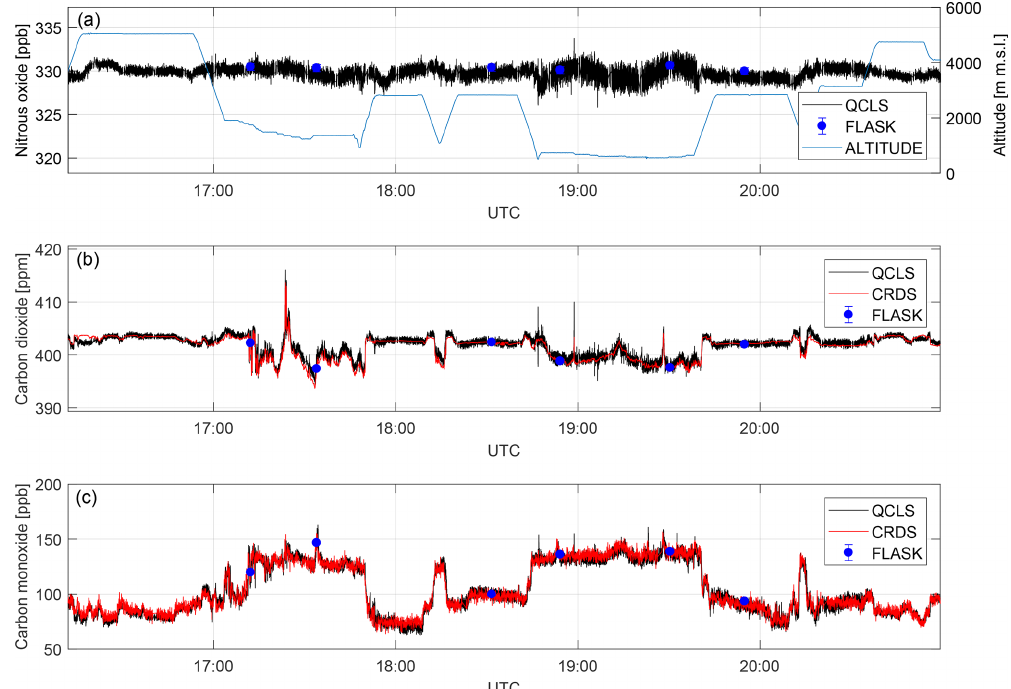
Figure 11. Dry-air mole fractions retrieved from different measurement techniques for a complete flight on 3 October 2017. Depicted are nitrous oxide (a) , carbon dioxide (b) and carbon monoxide (c) mole fractions.